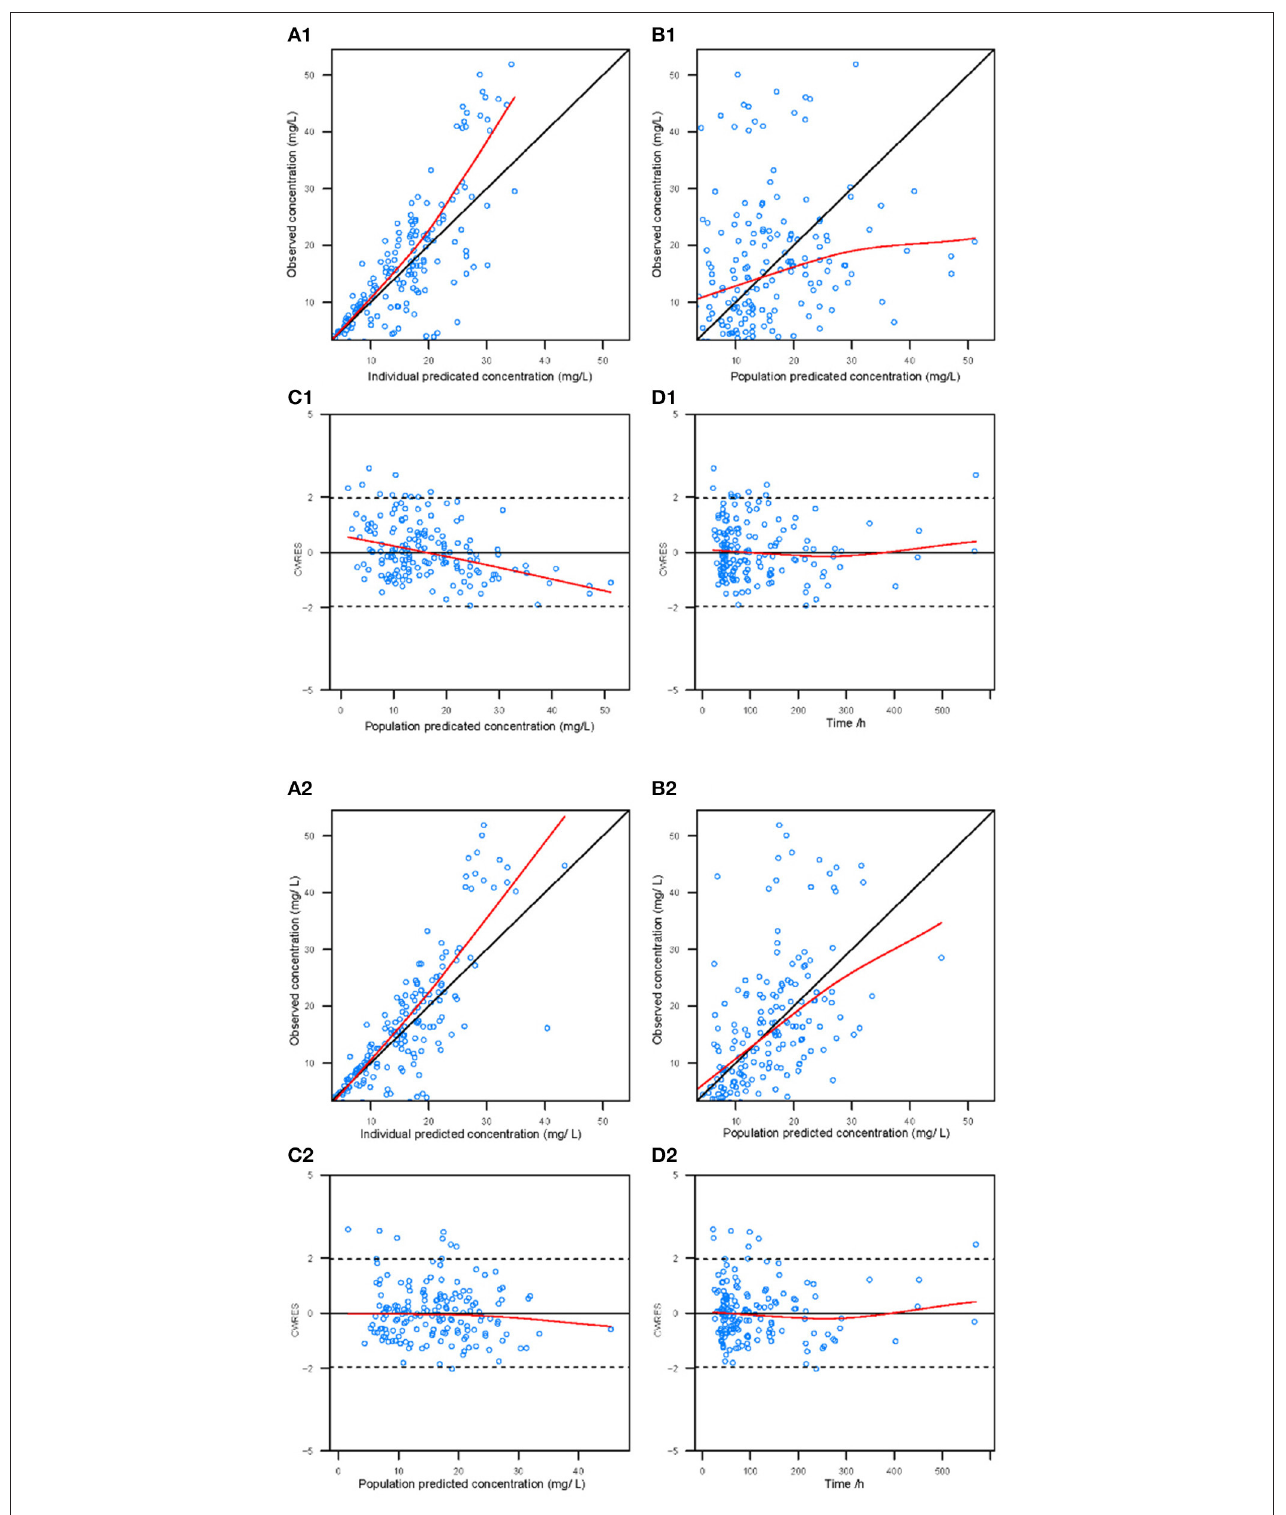
FIGURE 1 | Diagnostic goodness-of-fit plots for the base model (1) and the final model (2). (A) The individual predicted concentration (IPRED) vs. the observed concentration. (B) The population predicted concentration (PRED) vs. the observed concentration. (C) The PRED vs. the conditional weighted residual errors (CWRES). (D) The time after dose vs. CWRES. The black solid lines are the reference lines, and red solid lines are the loess smooth lines.